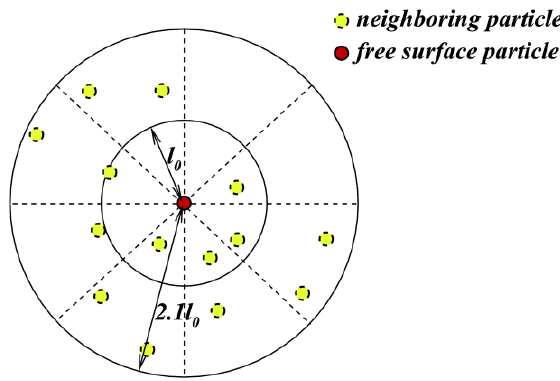
Figure 5. Schematic diagram of the secondary judgement.